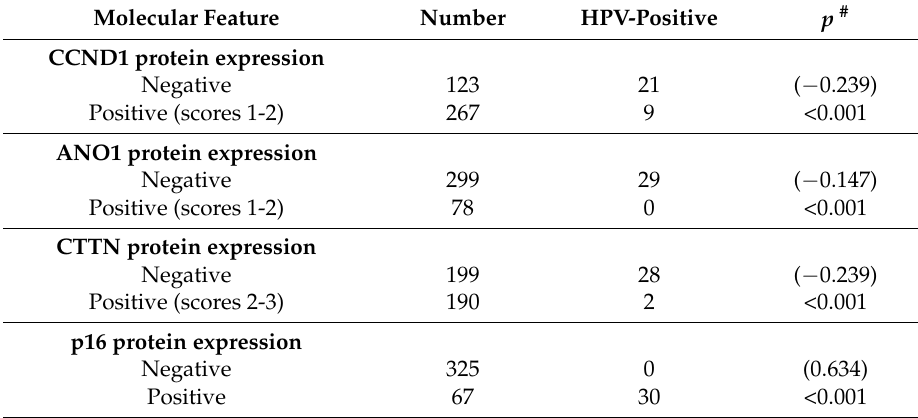
Table 1. Analysis of CCND1 (Cyclin D1), ANO1 (Anoctamin-1), and CTTN (Cortactin) protein expression in relation to human papillomavirus (HPV) status and p16 expression in 392 head and neck squamous cell carcinomas (HNSCC)